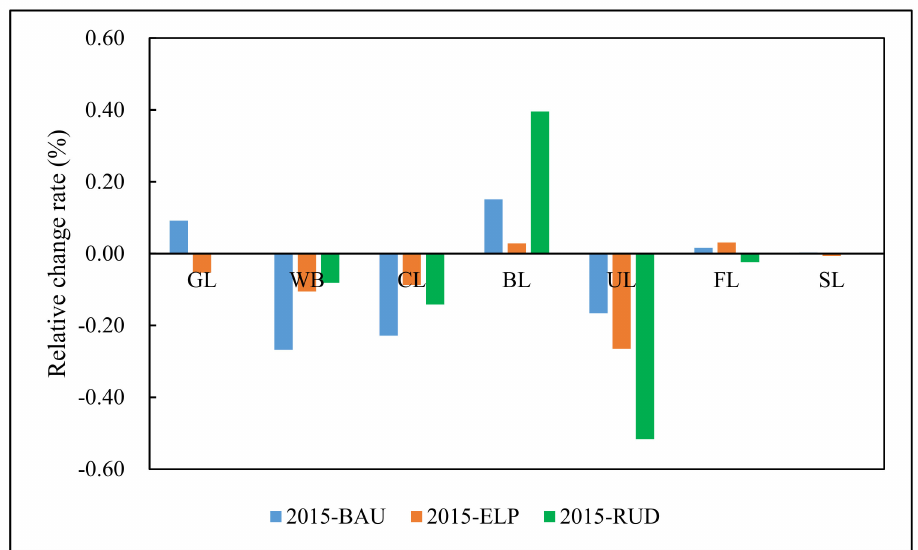
Figure 2. Land-use changes (%) from 2015 to 2030 under three scenarios in the ECA, GL (Grass Land), WB (Water Body), CL (Cultivated Land), BL (Built-up Land), UL (Unused Land), FL (Forest Land), SL (Shrub Land), BAU (Business as Usual), ELP (Ecological Protection), and RUD (Rapid Urban Development).